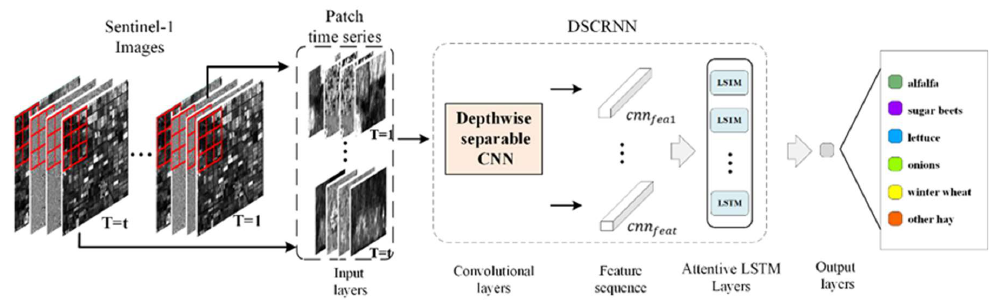
Figure 4. The general view of the proposed depthwise separable convolution recurrent neural network (DSCRNN).